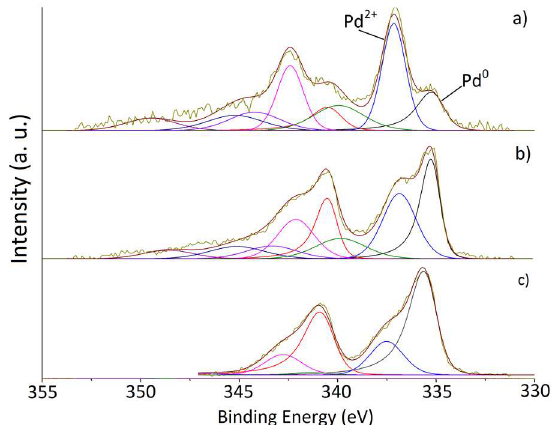
Figure 2. X-ray photoelectron spectroscopy (XPS) spectra of ( a ) Pd IMP /CNF, ( b ) Pd SI /CNF, and ( c ) Pd SI /AC.